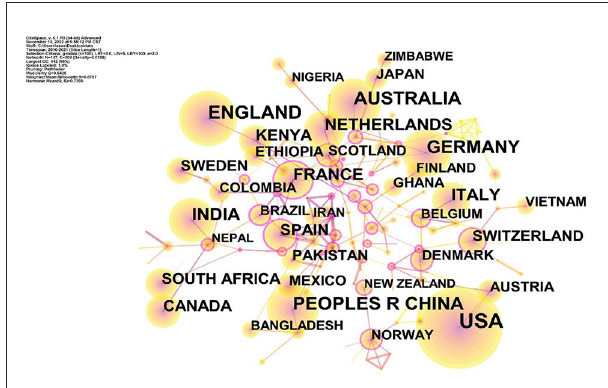
FIGURE3 A visualization of the country cooperation network. Each node represent a country, the larger the node, the more publication that country has. The line represent the connection between countries, the thicker the line, the closer relationship and the lighter color of the line, the later connection.